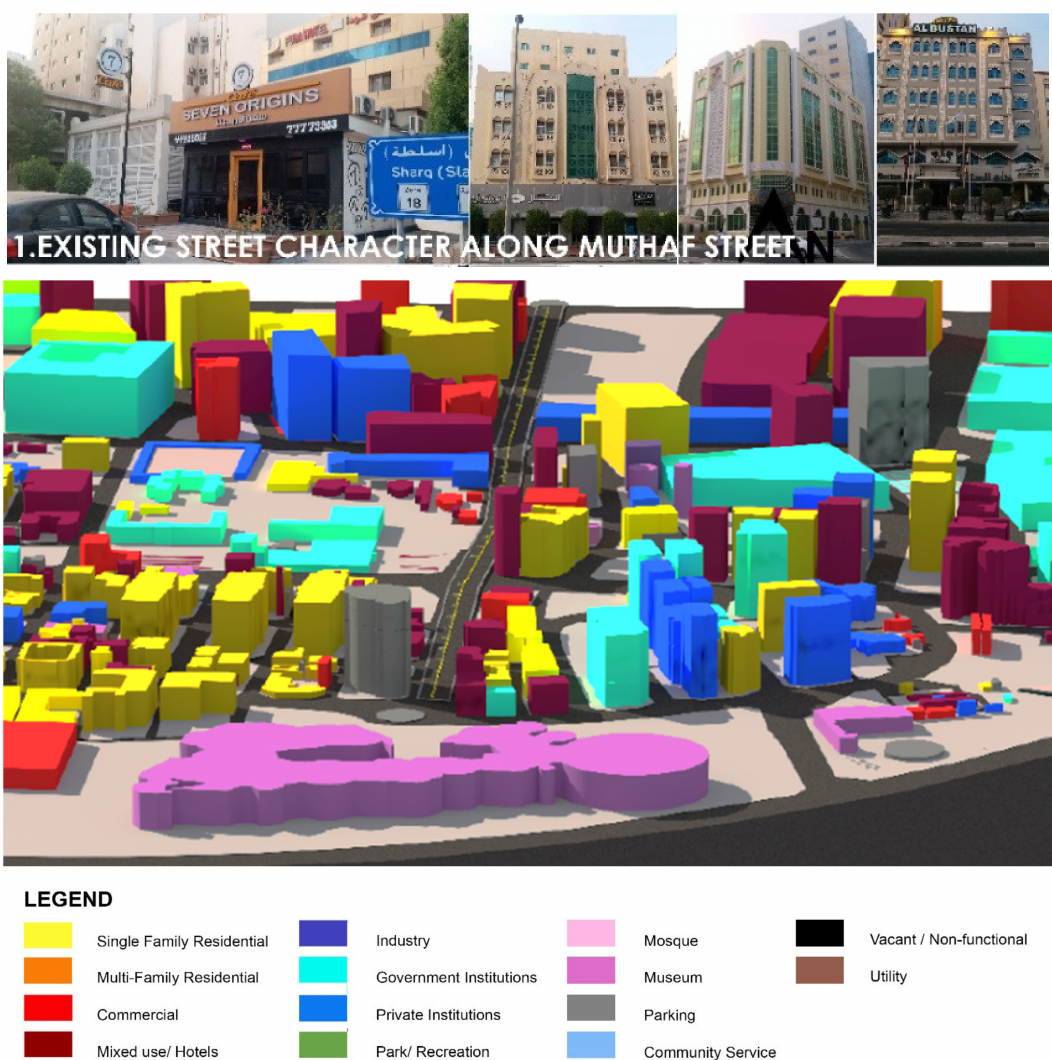
Figure 8. Street character along Muthaf